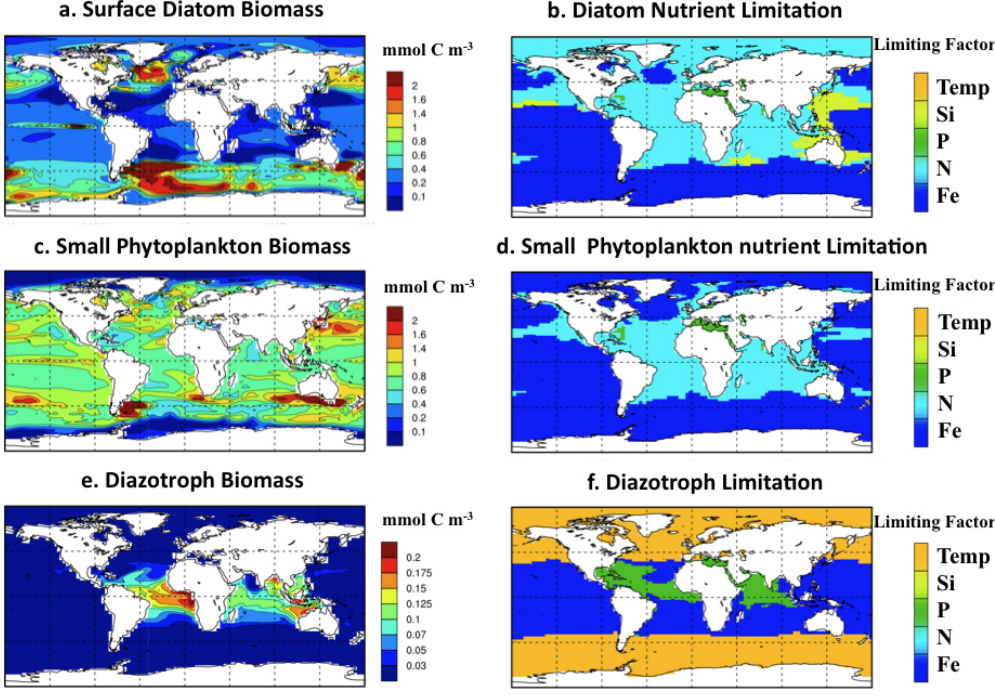
Fig. 1. Global maps of (a, c, e) surface diatom, small phytoplankton and dizotroph biomass in mmolC/m 3 as well as (b, d, f) the mixed layer depth limiting nutrients averaged over the control period, years